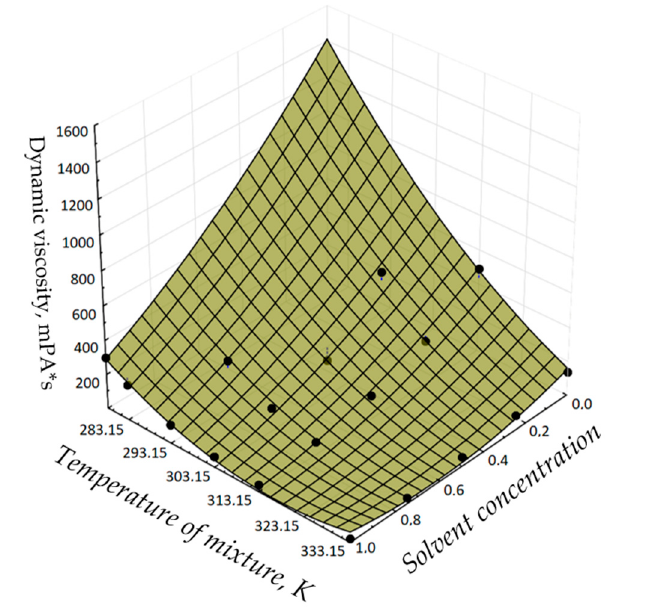
Figure 5. Experimental values of dynamic viscosity coefficient and surface constructed according to Equation (18) in the space «dynamic viscosity coefficient–temperature of mixture–concentration of solvent».